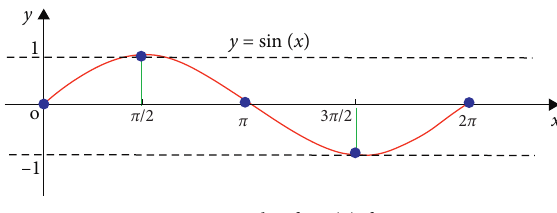
Figure 1: Graph of sin( x )